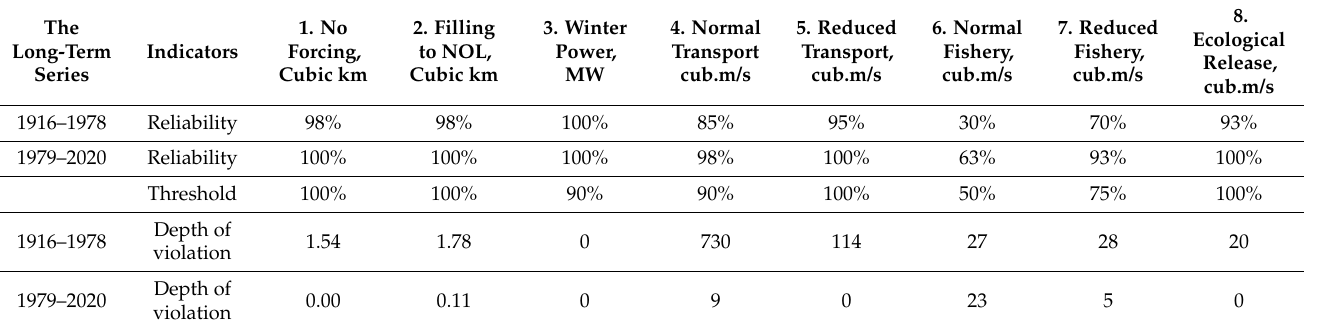
Table 10. Reliability for water users’ requirements and the depth of violations for the inflow series 1916–1978 and